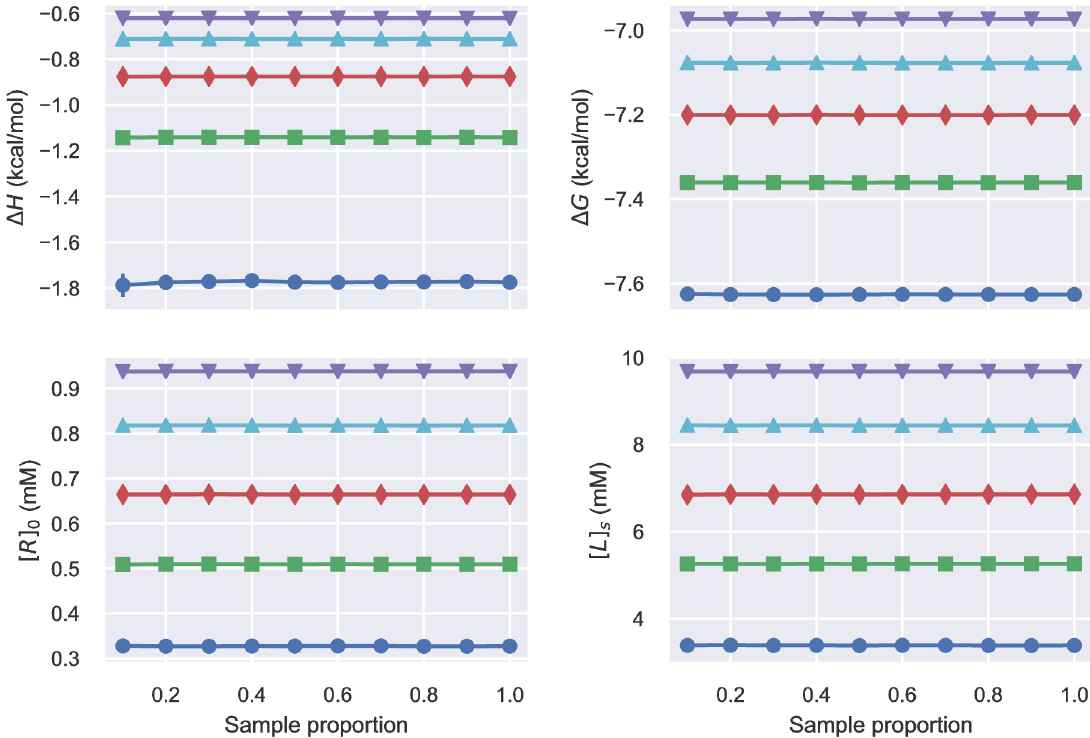
Fig 1. Convergence of percentiles of the Bayesian posterior of the 2C model based on the Fokkens_1a dataset. 20,000 samples were drawn from the Bayesian posterior using the NUTS sampler. Four key parameters are shown. Lines correspond to the 5-th (blue circle), 25-th (green square), 50-th (red diamond), 75-th (cyan upward triangle) and 95-th (magenta downward triangle) percentile. The error bars, which are too small to be visible, are standard deviations estimated by 100 bootstrapping samples. Similar plots for RM and EM models are shown in S1 and S2 Figs, respectively. S2 Fig also shows the convergence of percentiles for fits to a representative simulation of the EM